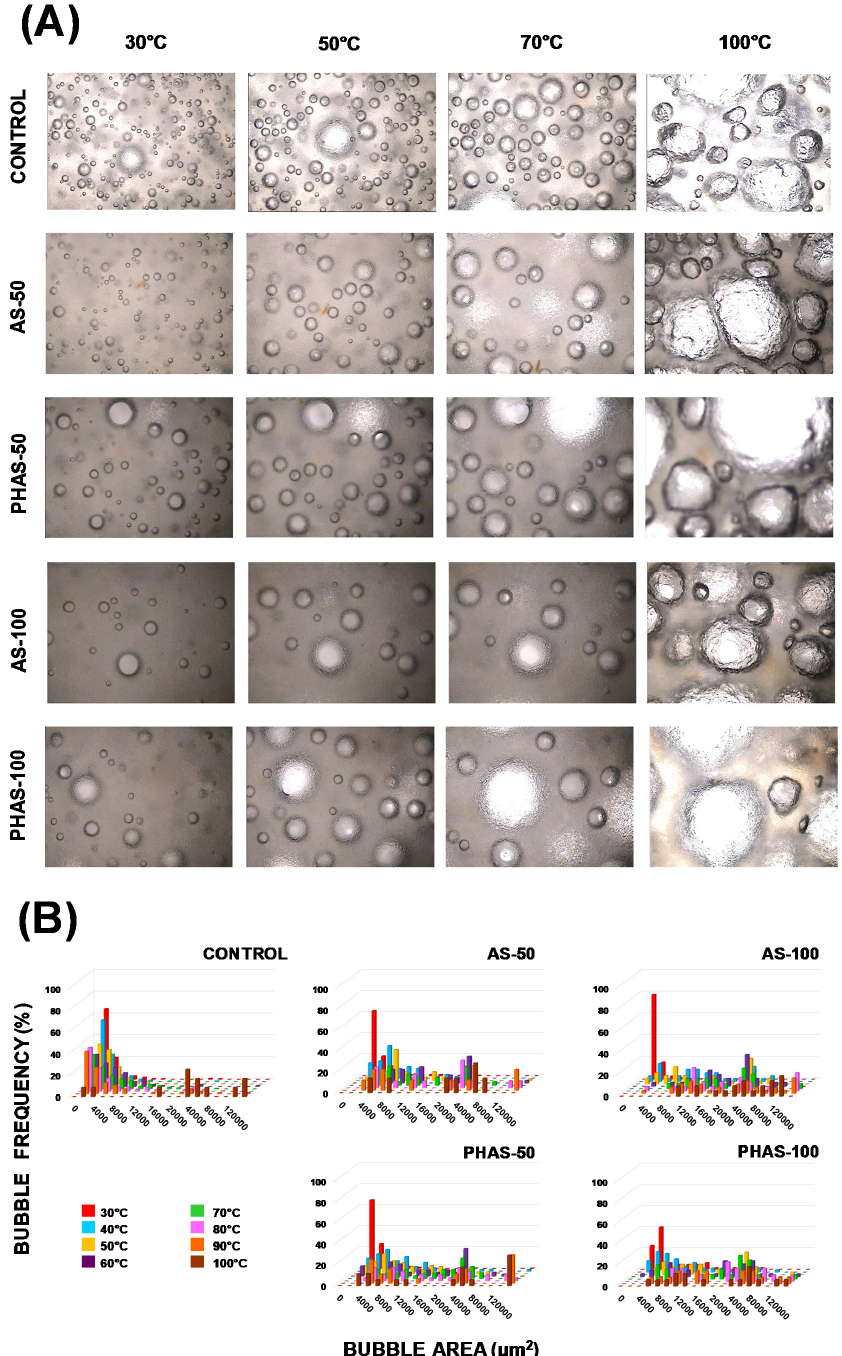
Figure 3. Changes in batters during micro-baking by baking temperature: ( A ) light microscopy images (4×) of bubble expansion; ( B ) bubble size distribution histograms.